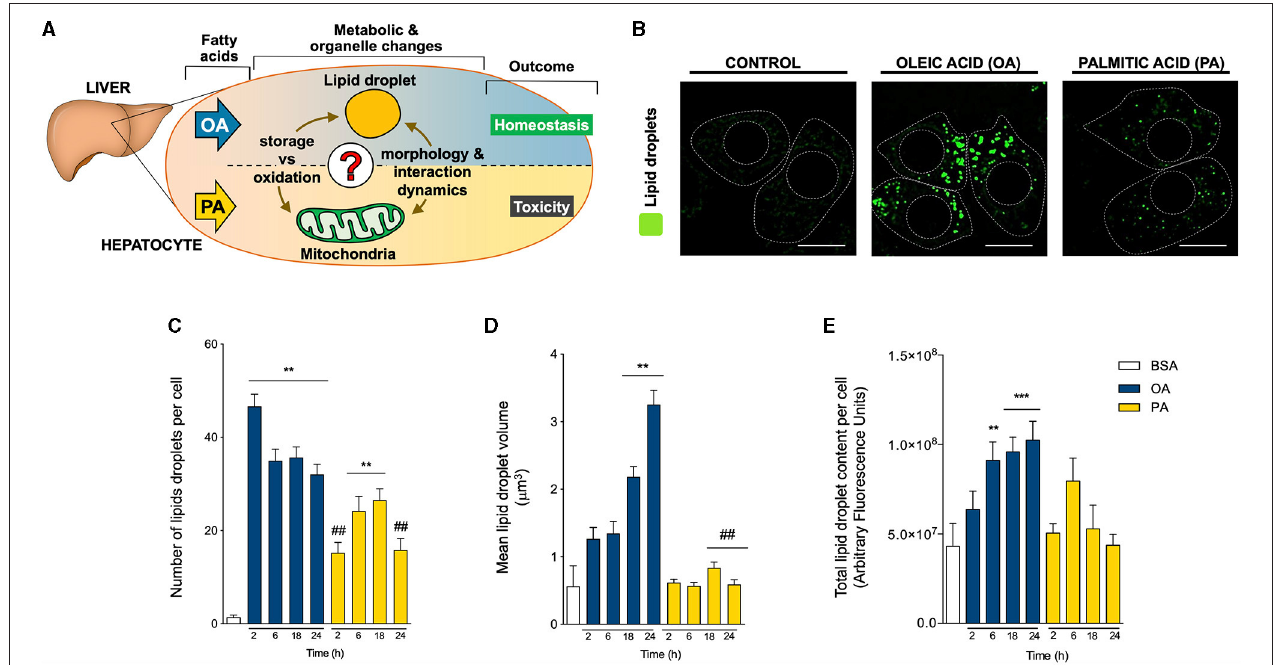
FIGURE 1 | Oleic and palmitic acids differentially remodel lipid droplet morphology in HepG2 cells. (A) In the liver, oleic acid (OA) overload seemingly does not damage hepatocyte function, while palmitic acid (PA) is evidently toxic. To date, the underlying mechanism of this difference remains unknown in terms of fatty acid metabolism and mitochondria-lipid droplet interactions and morphology. (B) Representative confocal imaging of HepG2 cells treated with 200 µ M of OA or PA during 18h and stained with Bodipy 493/503 (green) for lipid droplet (LD) visualization. Segmented lines represent the cellular and nuclear contours. Scale bar: 10 µ m. (C) Quantification of the number of LDs per cell in images treated as in A for 0–24h. (D) Mean individual volume of LDs in HepG2 cells treated as in A for 0–24h. (E) Quantification of the total Bodipy 493/503 fluorescence in HepG2 cells treated as in A for 0–24h. Data are from N = 6–20 cells analyzed from three independent experiments. Results are shown as mean ± SEM; * p < 0.05; ** p < 0.01; *** p < 0.001 vs. BSA; # p < 0.05; and ## p < 0.01 vs. OA at the same time